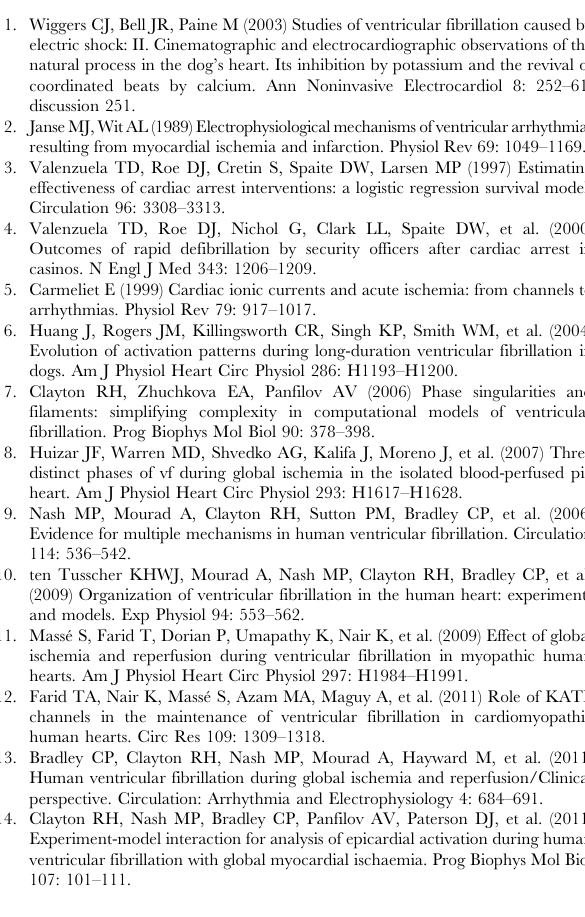
averaged over 1 s window with standard deviation. Blue: smoothed curve that we used for our fitting. Red: extracellular potassium concentration. Green: fraction of activated K ATP channels. (TIF) Figure S9 Evolution of hypoxia and hyperkalemia in the course of global ischemia for the patient H065 in [13], estimated by our fitting method. Pink: clinical data on the dominant frequency, averaged over 1 s window with standard deviation. Blue: smoothed curve that we used for our fitting. Red: extracellular potassium concentration. Green: fraction of activated K ATP channels. (TIF) Figure S10 Evolution of hypoxia and hyperkalemia in the course of global ischemia for the patient H066 in [13], estimated by our fitting method. Pink: clinical data on the dominant frequency, averaged over 1 s window with standard deviation. Blue: smoothed curve that we used for our fitting. Red: extracellular potassium concentration. Green: fraction of activated K ATP channels.